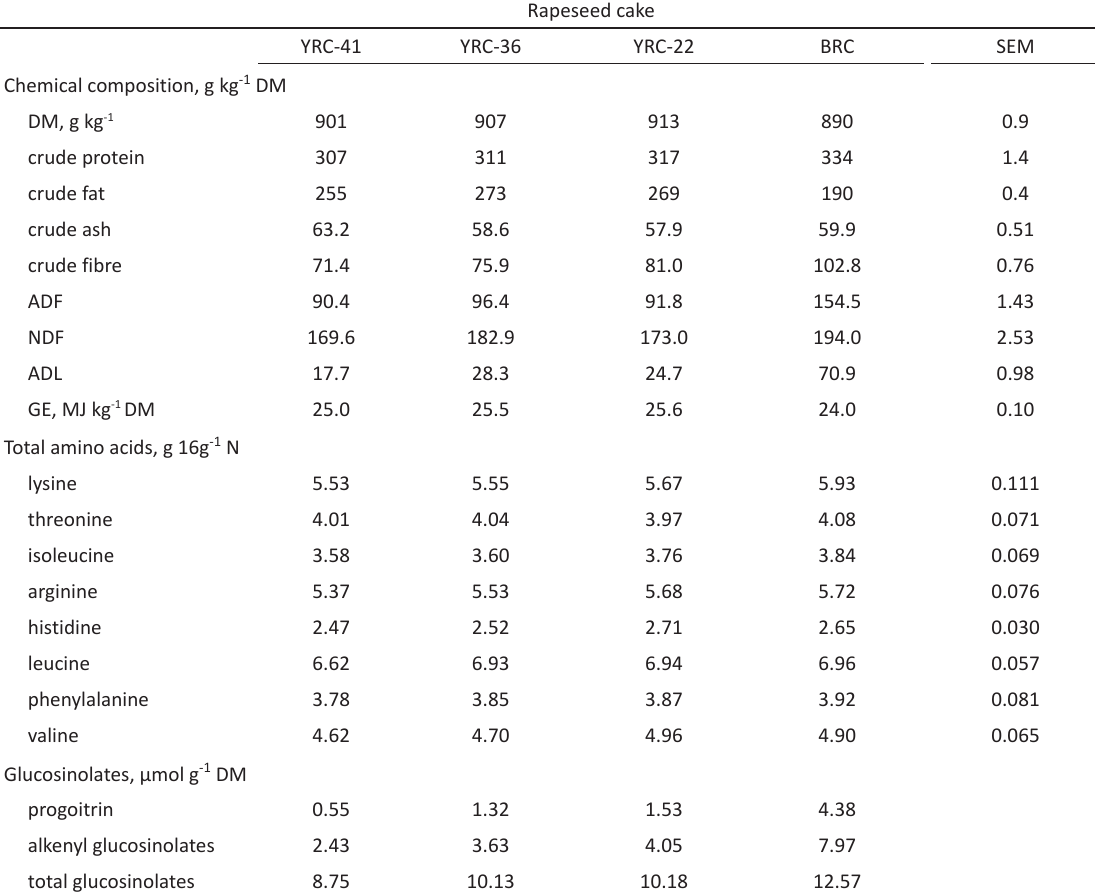
Table 3. Composition of yellow- and brown-seeded rapeseed cakes Rapeseed cake YRC-41 YRC-36 YRC-22 BRC SEM Chemical composition, g kg -1